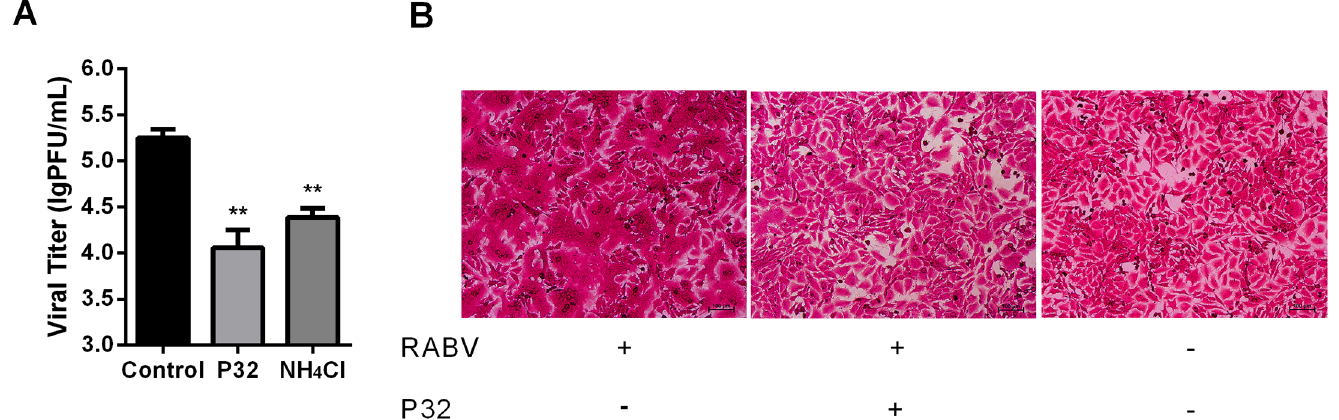
Fig 6. P32 affects cell fusion mediated by RABV G protein. (A) Viral titers in response to P32 treatment during the post-internalization period. NA cells were infected with SAD-L16 at an MOI of 0.01 and subjected to the post-internalization inhibition assay, after which viral titers were determined. Each value is expressed as the mean ± SEM from three independent experiments ( * , P < 0.05; ** , P < 0.01; *** , P < 0.001; **** , P < 0.0005). (B) P32 inhibits G protein- mediated cell membrane fusion. The low pH-dependent membrane fusion assay was performed in RABV-infected BSR cells. Briefly, BSR cells were infected with SAD-L16 at an MOI of 5 at 37°C for 48 h. After viral infection, cells were treated with MM containing P32 or vehicle at 37°C for 2 h, after which the cells were washed and incubated with fusion medium for 2 min at room temperature. Then, the fusion medium was discarded, and MM was added to the cells, which were incubated at 37°C for another 2 h. The cells were then fixed with 80% ice-cold acetone and stained with fuchsine solution.